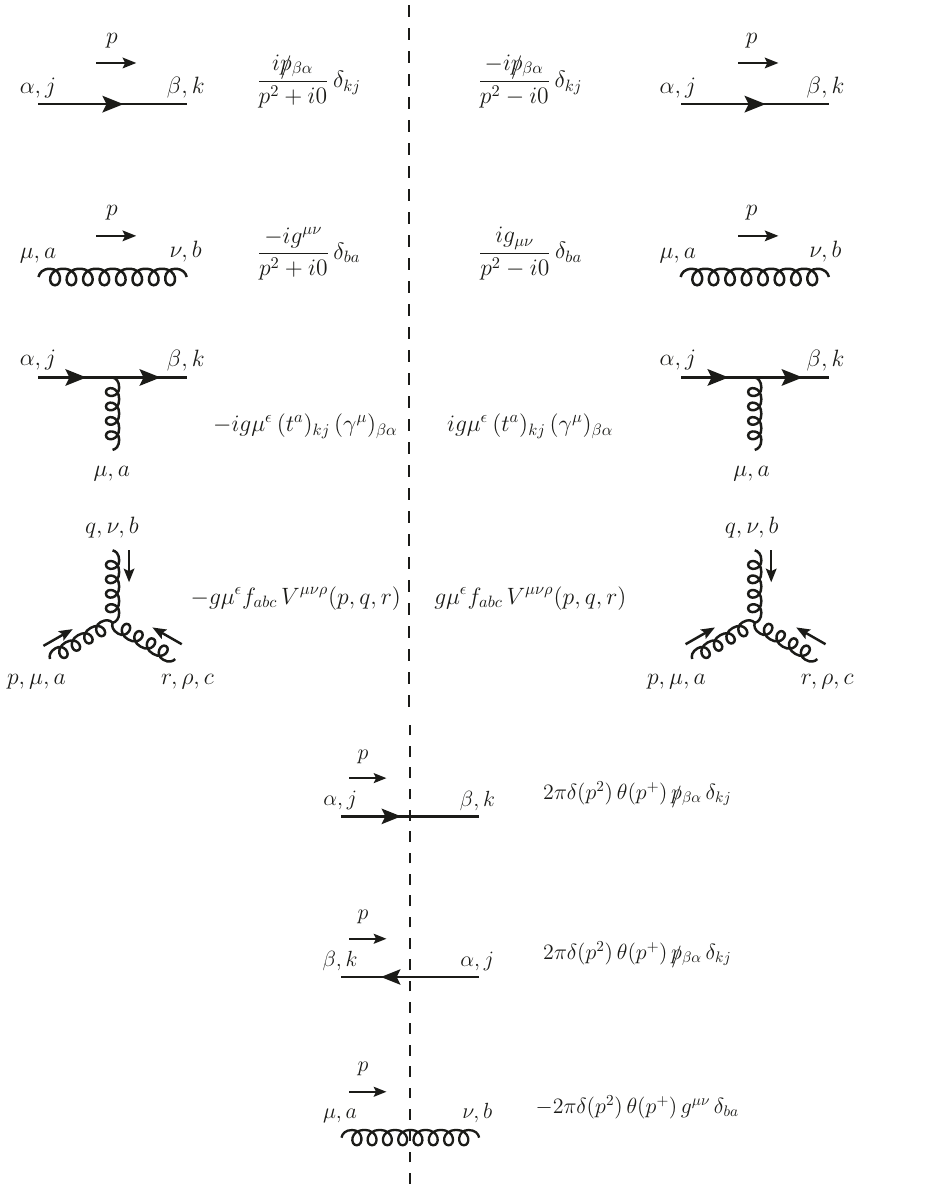
Figure 12. Feynman rules for propagators and vertices in cut graphs. We use Feynman gauge and set the quark mass to zero. V µνρ ( p, q, r ) is defined in (D.1). With these rules for cut quark and antiquark lines, there is no minus sign for a closed fermion loop going across the